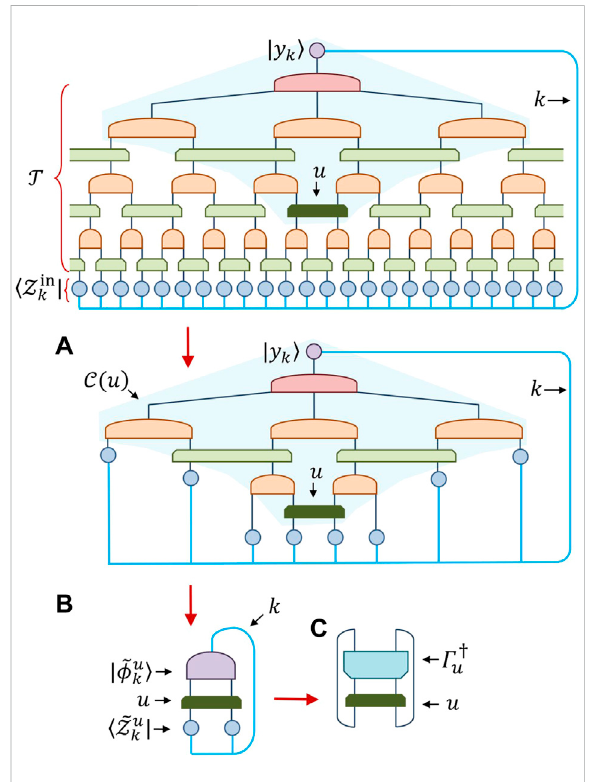
FIGURE 7 The sequence of steps used to evaluate the environment Γ u of the shaded tensor u . (A) The initial state 〈 Z in k | is transformed through thenetwork to form anew number state on theboundary of thecausal cone C ( u ) associated to u . (B) The con fi guration space | ~ ϕ u k 〉 , de fi ned on the output indices of u , is computed through use of the left/right lowering operators, as in Figure 6. (C) The environment Γ is formed by taking the outer product of the con fi guration space | ~ ϕ k 〉 with the state 〈 ~ Z u k | de fi ned the input of u , summing over all training samples k , see also Eq.